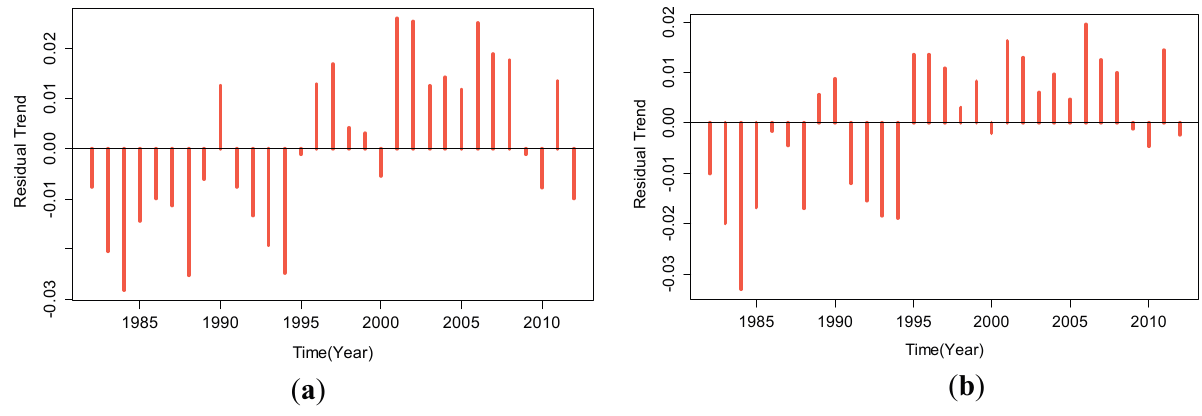
Figure 6. Temporal trend of annual NDVI residuals from RESTREND from 1982 to 2012 averaged over all pixels in the study region, adjusted for ( a ) soil moisture and ( b ) rainfall. Note difference of scale.